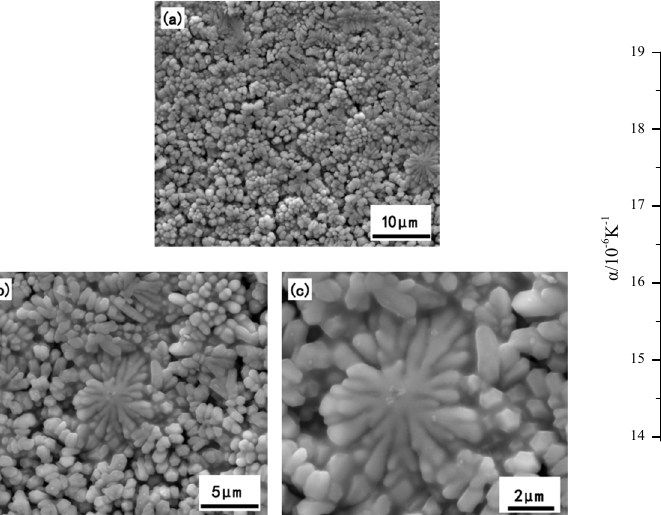
Figure 12: Thermal expansion coe ffi cient of Al – Mn – Fe alloy at dif - ferent temperature stages during casting and injection